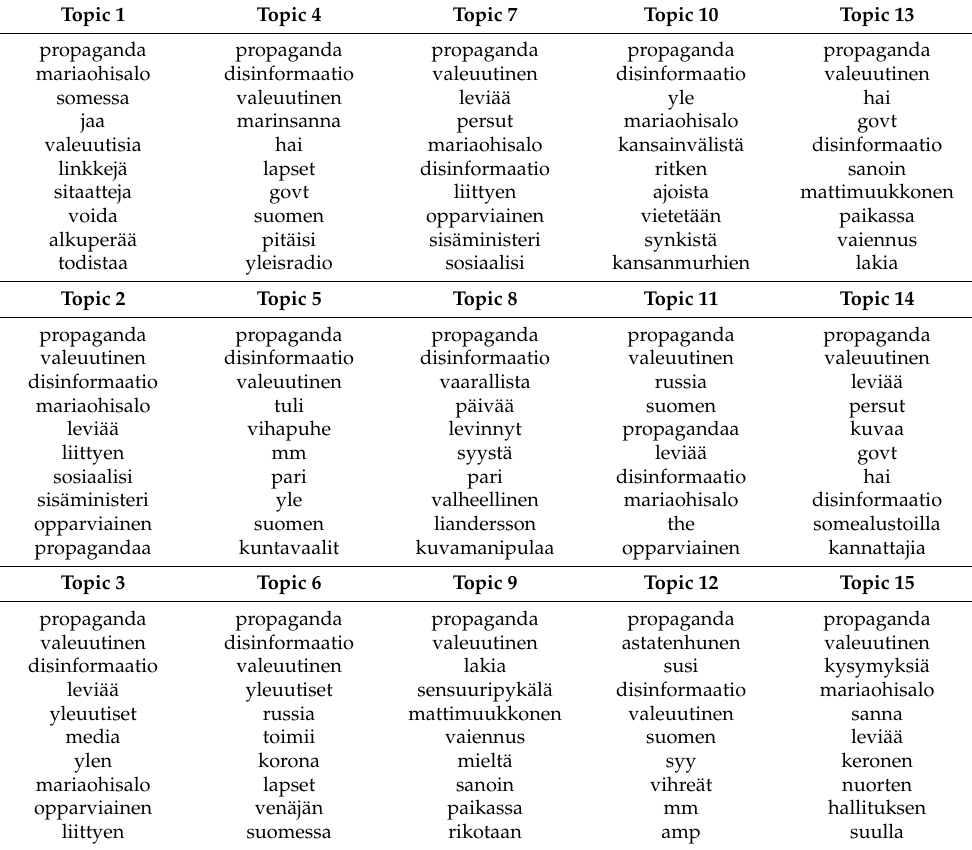
Table 5. Top 10 words in 15